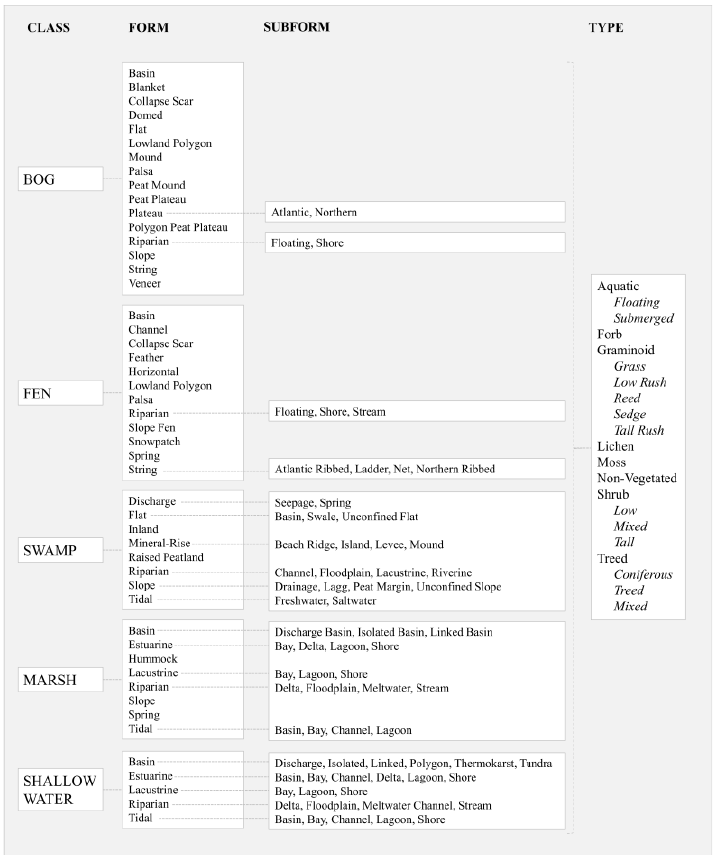
Figure 5. Canadian Wetland Classification System. 260